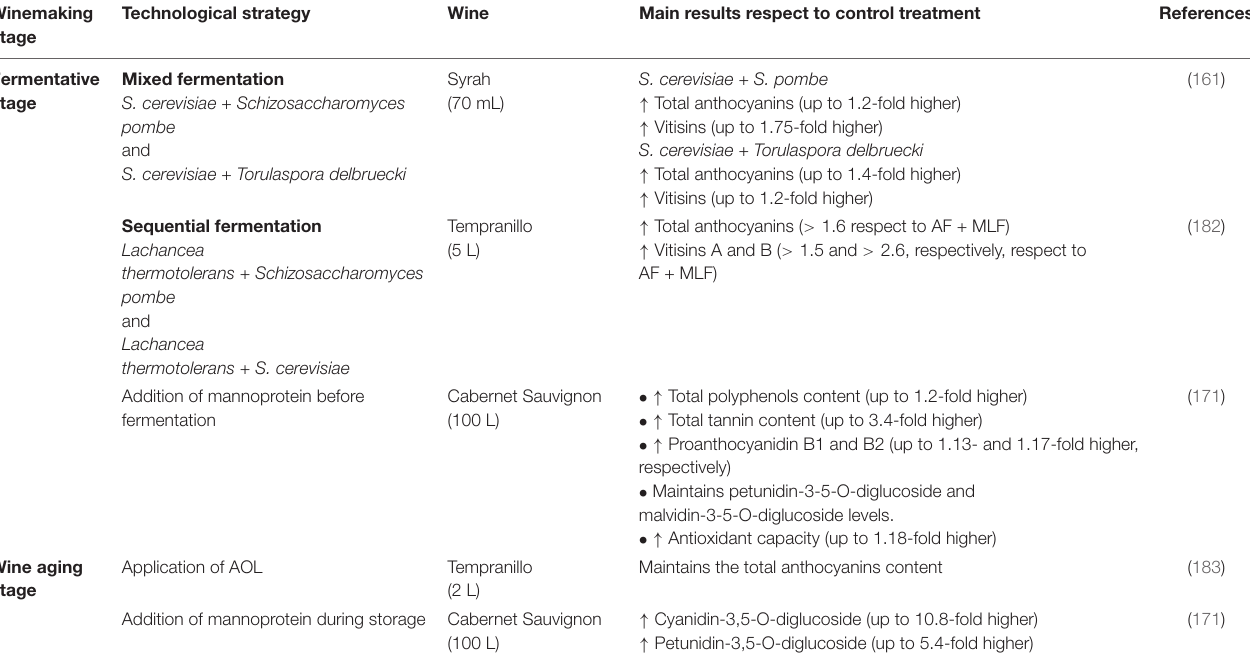
TABLE 5 | Strategies applied at the fermentative level and during the aging of red wines to improve and/or maintain the content of phenolic